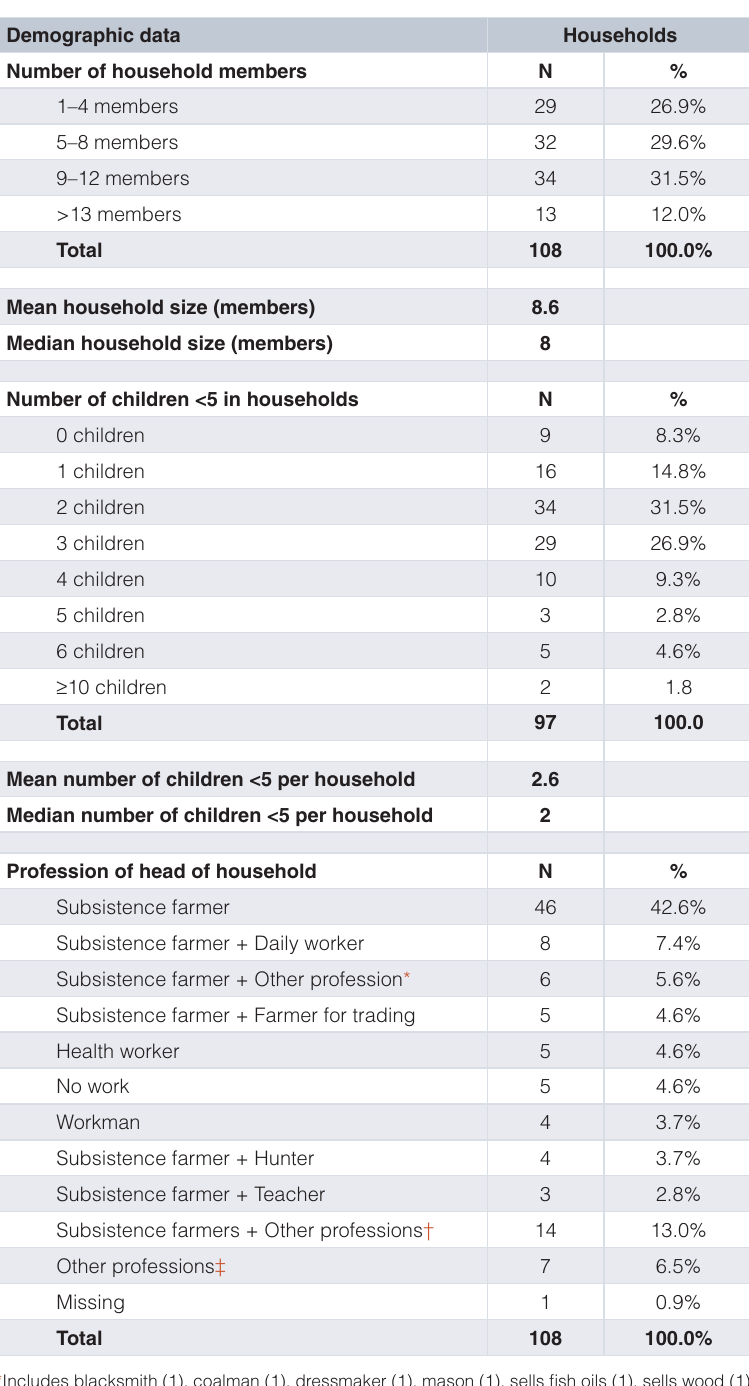
Table 4. Socio-demographic description of the study